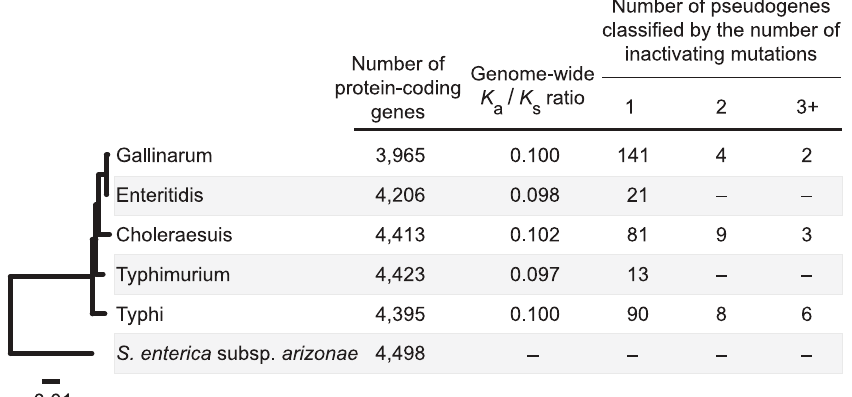
Figure 1. Distribution of pseudogenes among Salmonella genomes. The phylogenetic tree was inferred from 2,898 single-copy genes shared by all five S. enterica subsp. enterica strains and the outgroup S. enterica subsp. arizonae .